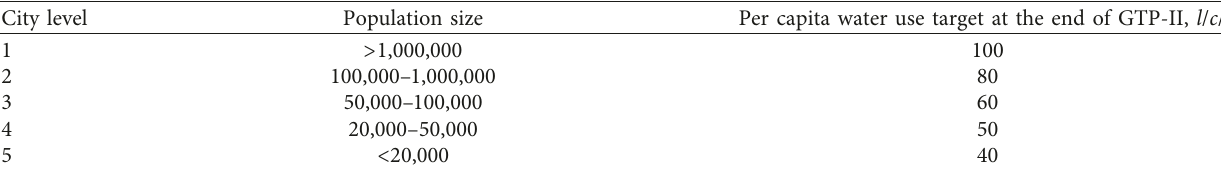
Table 1: Urban categories according to